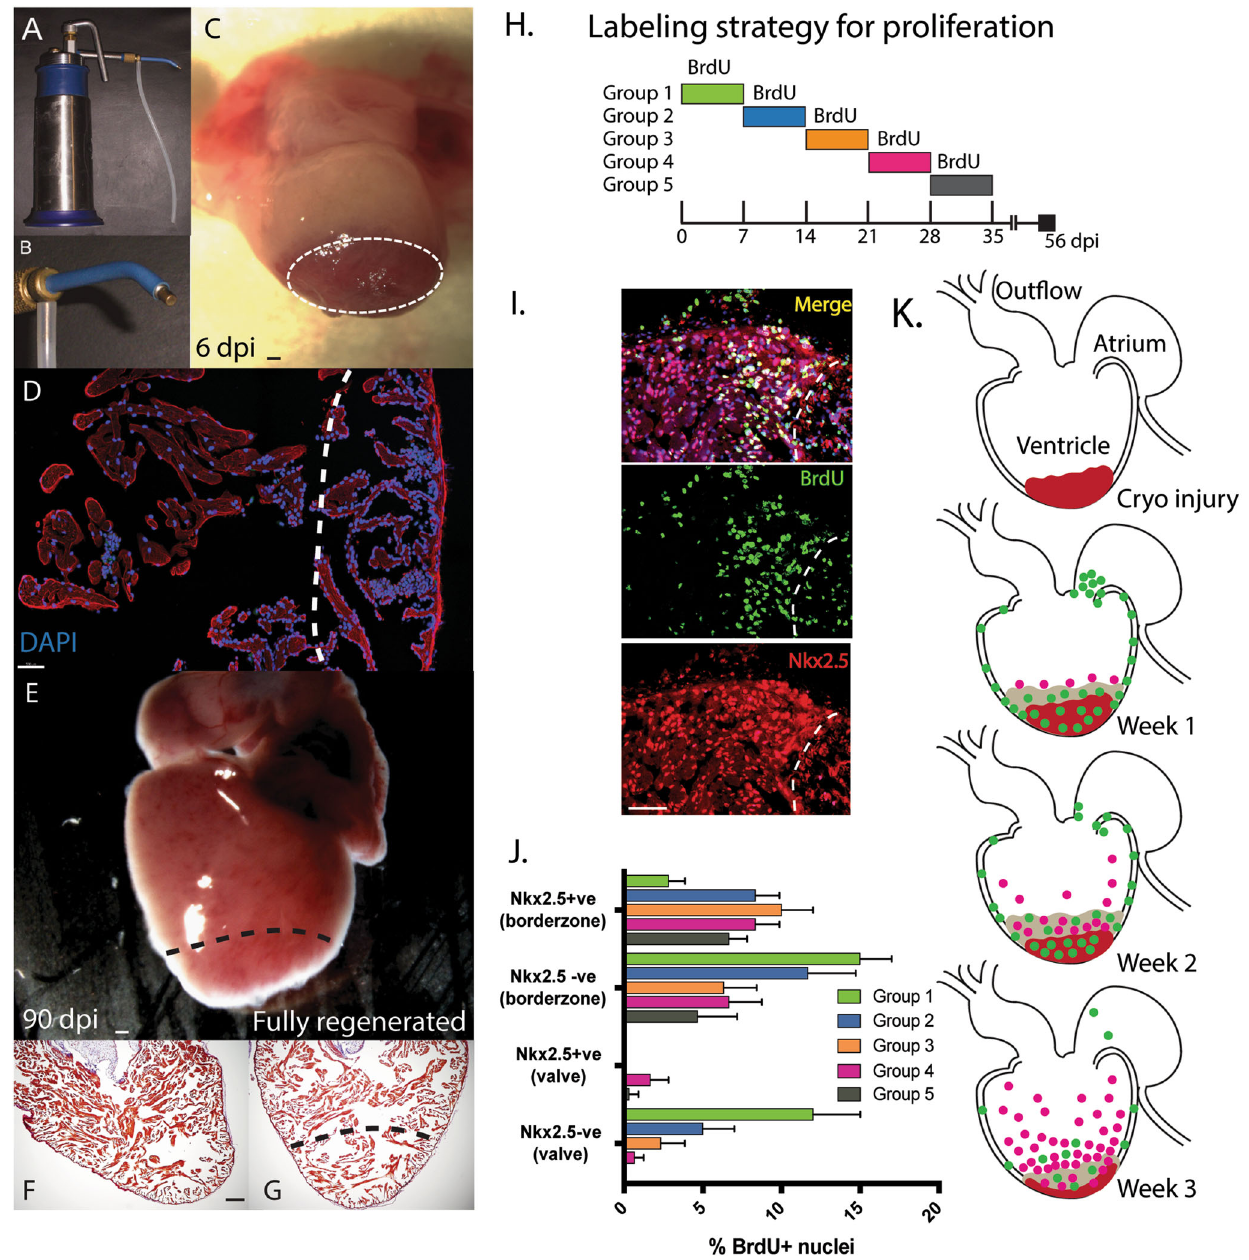
Fig. 1 Proliferation of cardiomyocytes during cardiac regeneration post cryo-injury. a A commercial liquid nitrogen cooled cryo-gun was used to generate a cryo-lesion at the apex of the heart. b Different gold tip attachments allowed matching to animal size. c A necrotic lesion was produced with edema still present at 6-days post injury (Dpi). d The lesion was identi fi ed by a robust in fl ammatory in fi ltrate with visible peripheral nuclei (DAPI) at 6 dpi. The ventricle was fully regenerated by 60 – 90 dpi and appeared normal, both super fi cially e , and histologically f , relative to uninjured controls. g Histological staining was performed with Acid Fuchsin orange G (AFOG) whrere collagen stains blue, muscle of the myocardium in orange/red and the nucleus black. h Time course of Bromodeoxyuridine (BrdU) labelling of animals daily (i.p. injection). i Identi fi cation of cardiomyocyte (CM) speci fi c proliferation used nuclear localized Nk2.5 antibody staining and dual positive BrdU+ ( Green )+ Nkx2.5+ cells ( Red ). j CM speci fi c and non-CM proliferation was measured during the fi rst 5 weeks of regeneration within 200 μ M of the borderzone or 100 μ M of the valve region (at the junction between the atrium and the ventricle). At least three sections per animal and three animals per time-point were used. k Cartoon of the general spatial localization of CM and non-CM proliferation in the axolotl heart over the fi rst 3 weeks of regeneration. Non-cardiomyocytes shown in green and Nkx2.5+ CM shown in pink. Cryo lesion in ventricle shown in red . Scale bar = 100 μ